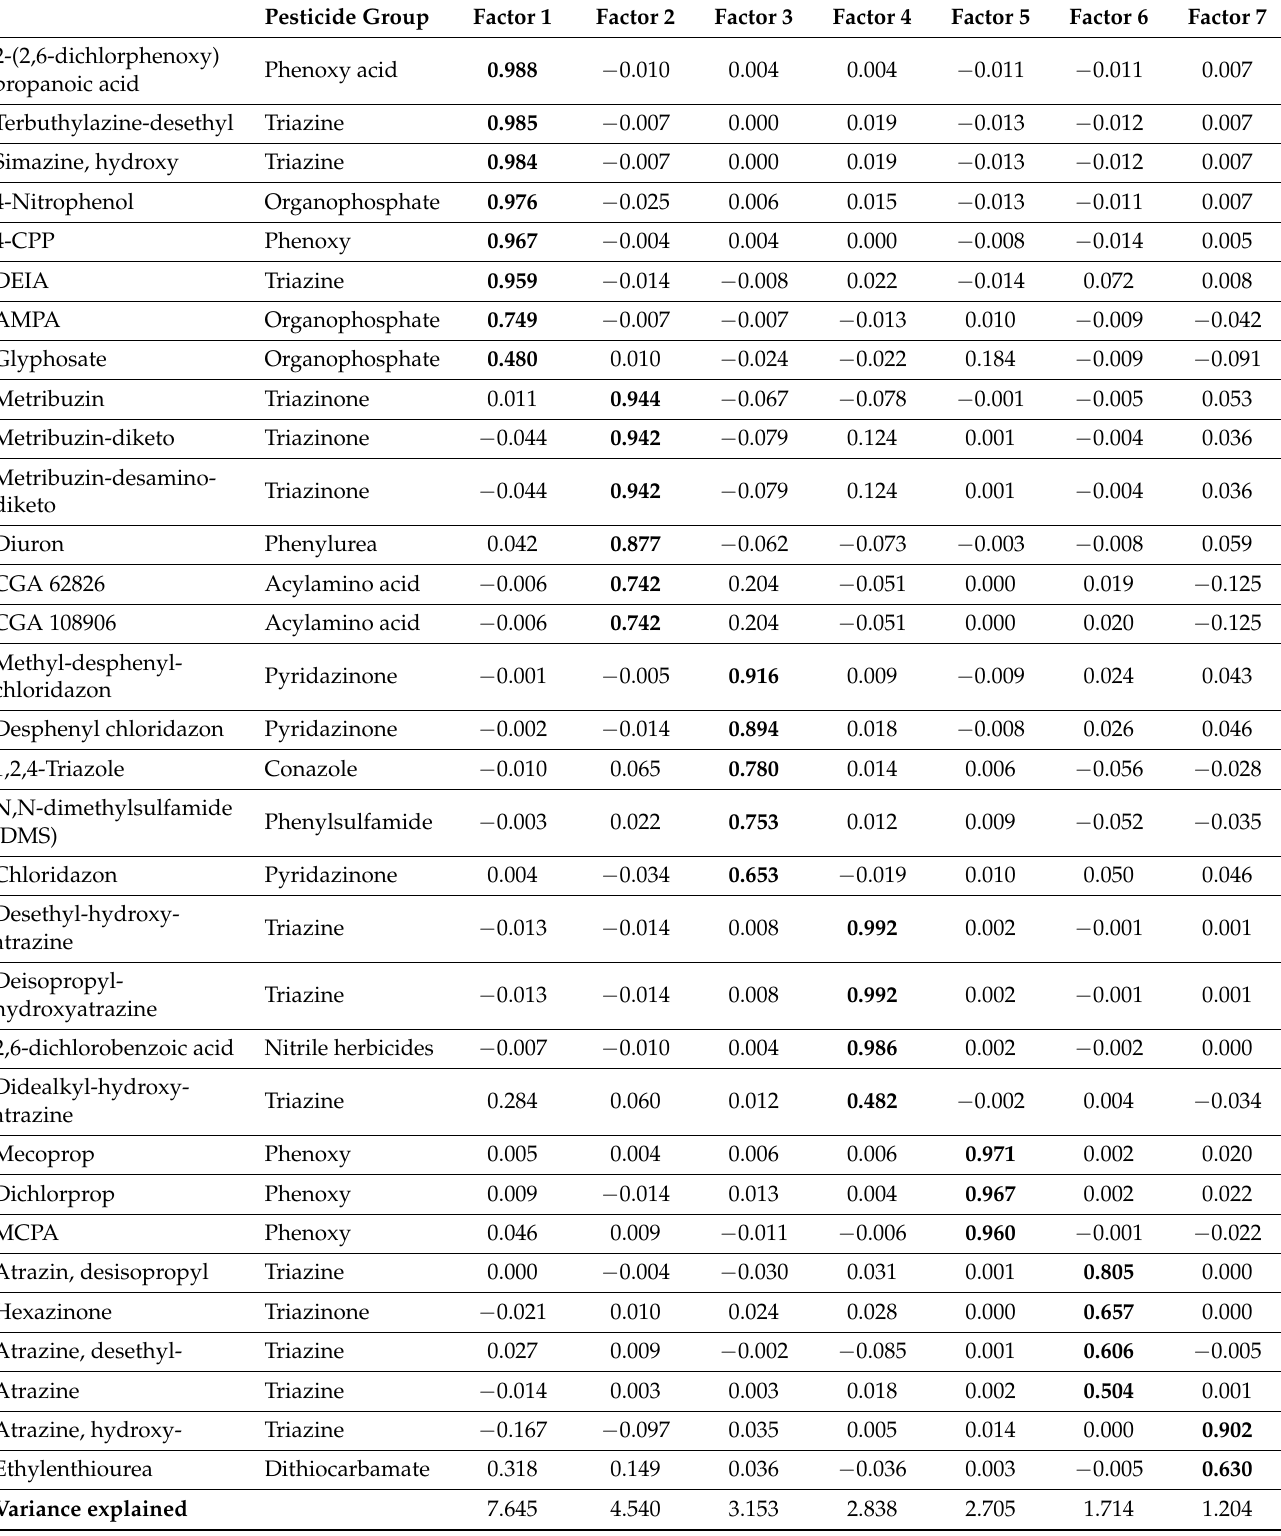
Table 2. Resulting factor pattern for the factor analysis 2012–2018. Loading scores are marked in bold if they meet the criterion of a loading score >0.45 or < −